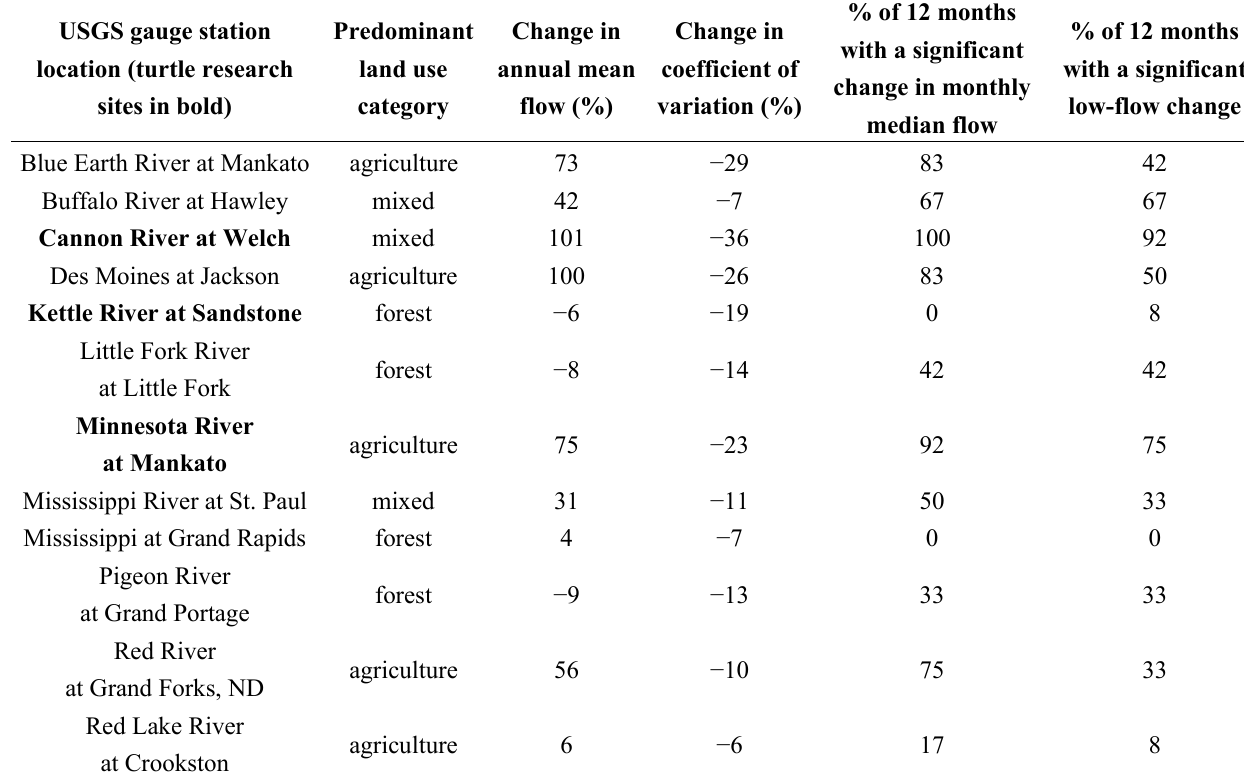
Table 2. Summary data for the Indicators of Hydrologic Alteration (IHA) analysis of 16 watersheds in Minnesota. Flow in the 1980–2009 time period was compared to that of the 1940–1979 time period by statistics calculated in IHA. Columns 1–2 describe the USGS stream gage location. Column 3 lists the percentage (%) change in the annual mean flow. Column 4 lists the change in the coefficient of variation (C.V.), a measure of stream flow variability of the daily average flows over a year. Column 5 lists the percentage of the 12 calendar months with a significant change in monthly median flow, as determined in IHA at the alpha = 0.05 level. Column 6 shows the percentage of months with a significant low-flow change (the lowest mean daily flow for each of the 12 months)